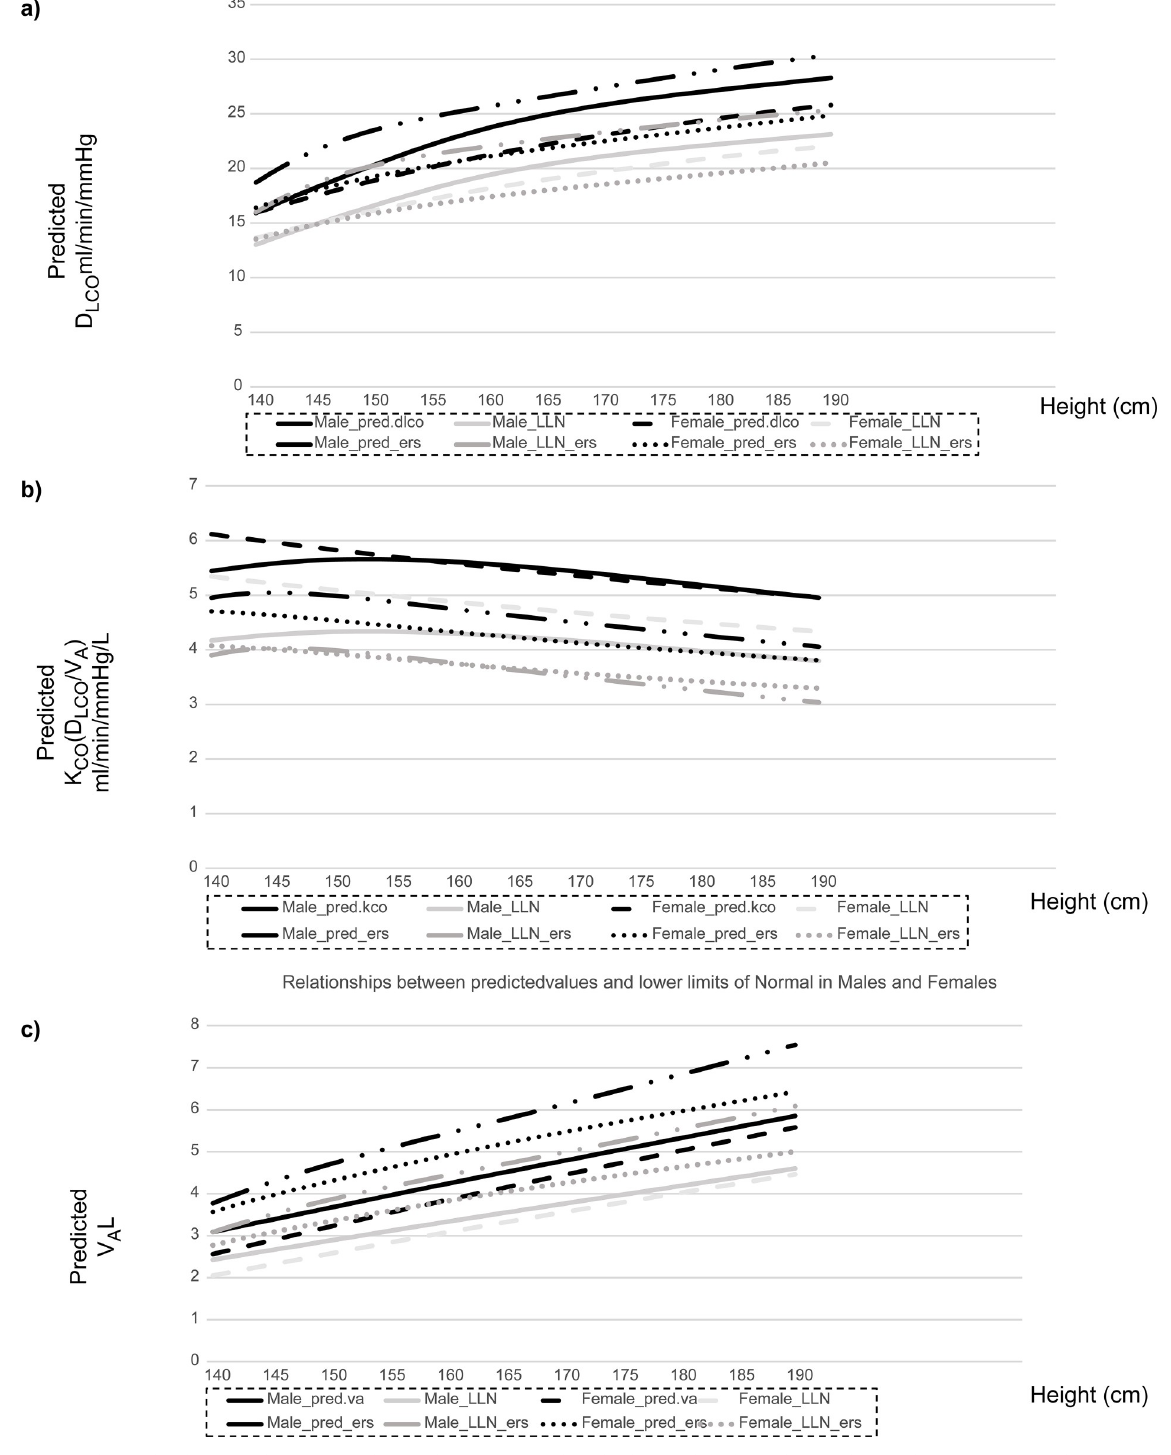
Fig 3. Relationship between the current values and GLI-2017 predicted values and the lower limits of normal in Japanese population (n = 390), aged 60 years and of different heights. Abbreviations: D LCO , single breath diffusing capacity for carbon monoxide; K CO , single breath diffusing capacity for carbon monoxide per unit of lung volume; LLN, lower limits of normal; and V A , alveolar volume.